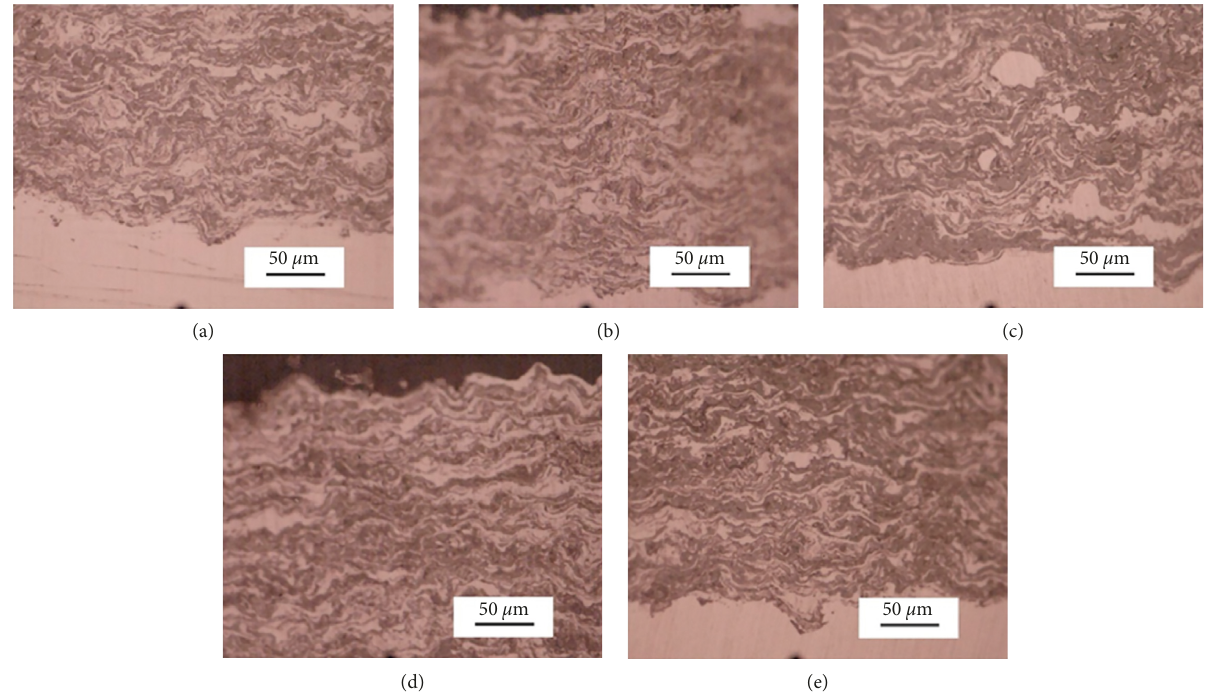
Figure 5: OM images of NiTinol coatings’ cross section of samples A (a), B (b), C (c), D (d), and E (e).